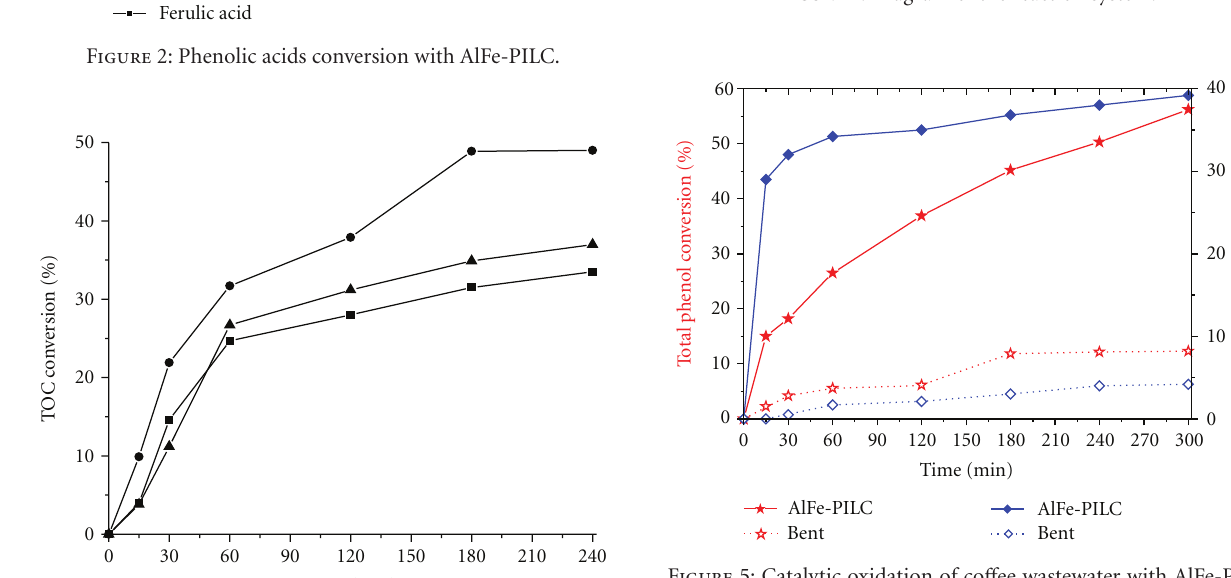
Figure 4: Diagram of the reaction system.